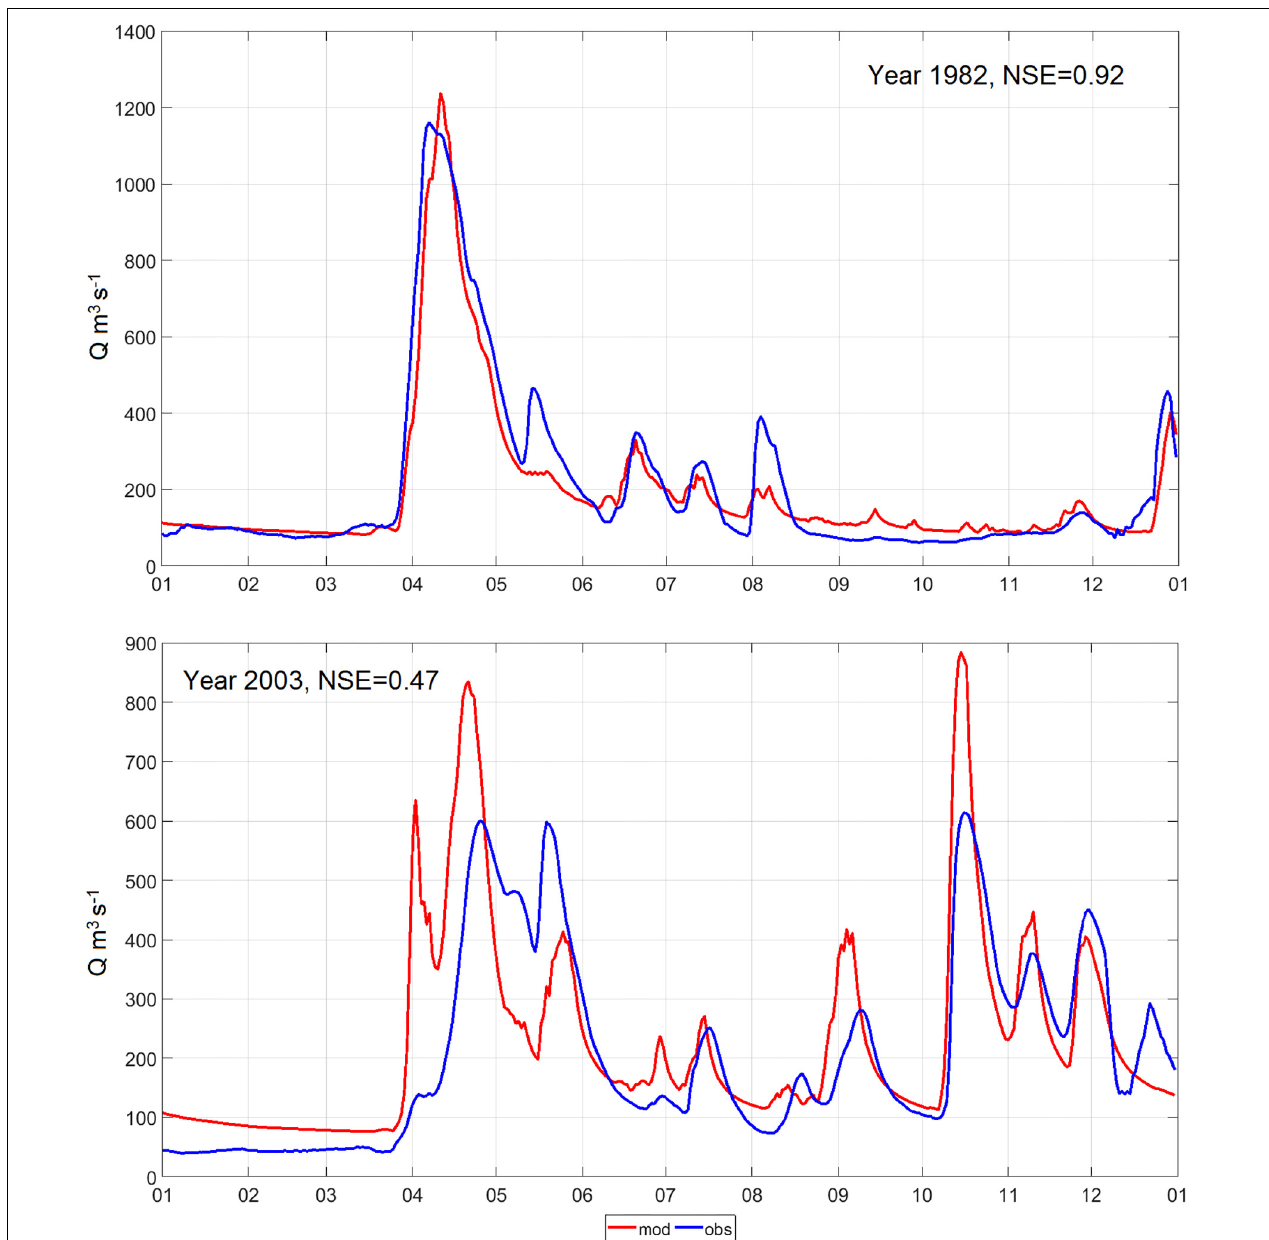
FIGURE 4 | The results of the historical simulating of streamflow on the Western Dvina River at the Vitebsk gauging station. The upper figure presents the best coherence of the observed and modeled streamflow in 1982, the bottom figure presents the worst simulated results for